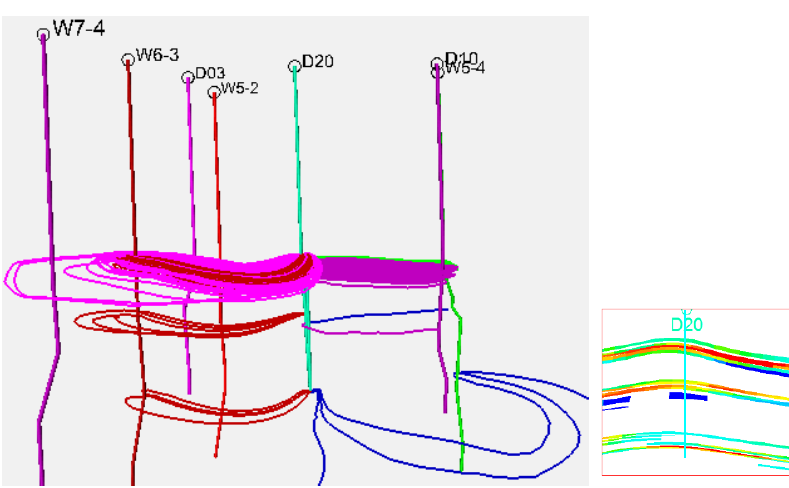
Figure 14. The vertical water streamline model of the well D20.